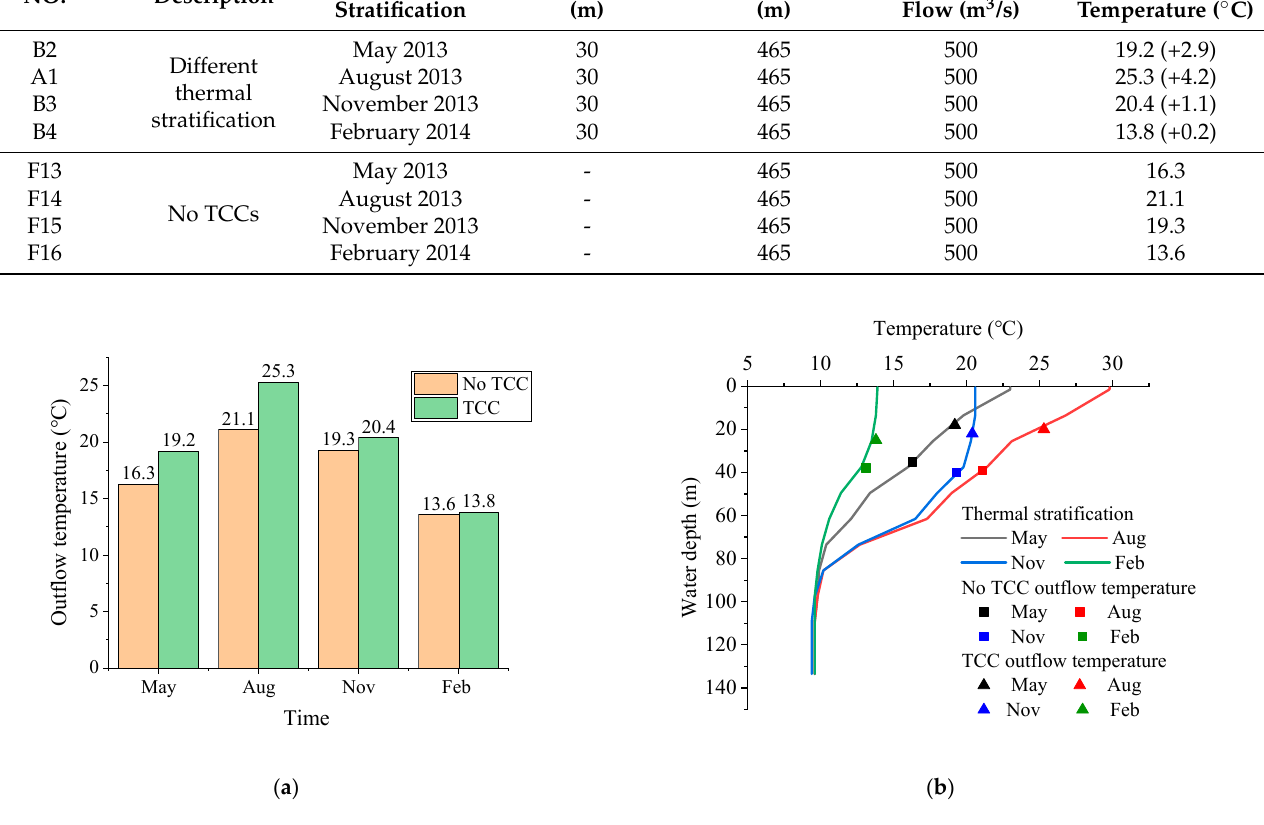
Figure 10. Comparison of outflow temperature: ( a ) before and after TCC implementation; ( b ) different